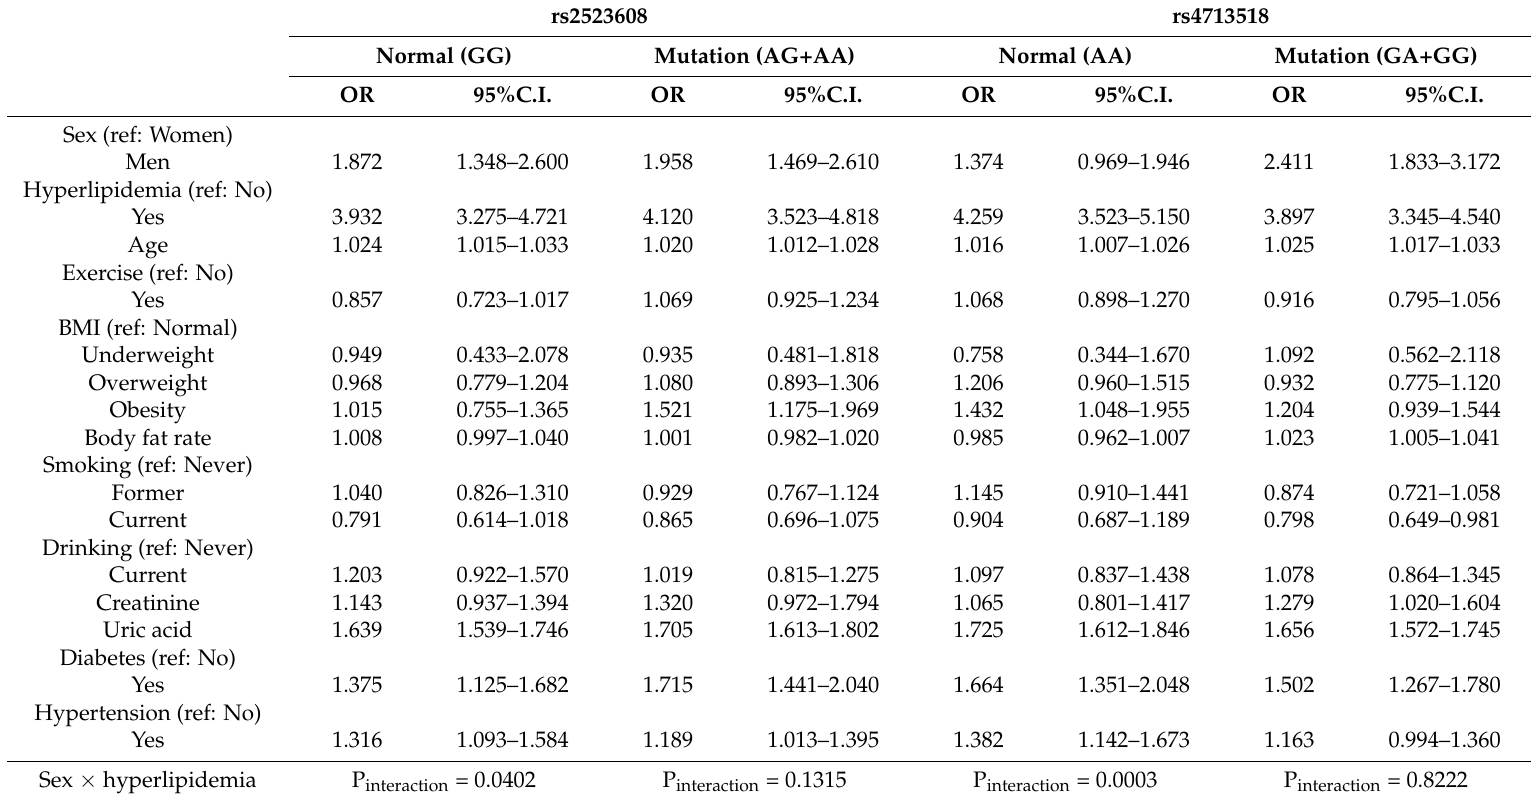
Table 3. Association of sex and hyperlipidemia with gout risk among carriers of HLA-B polymorphic